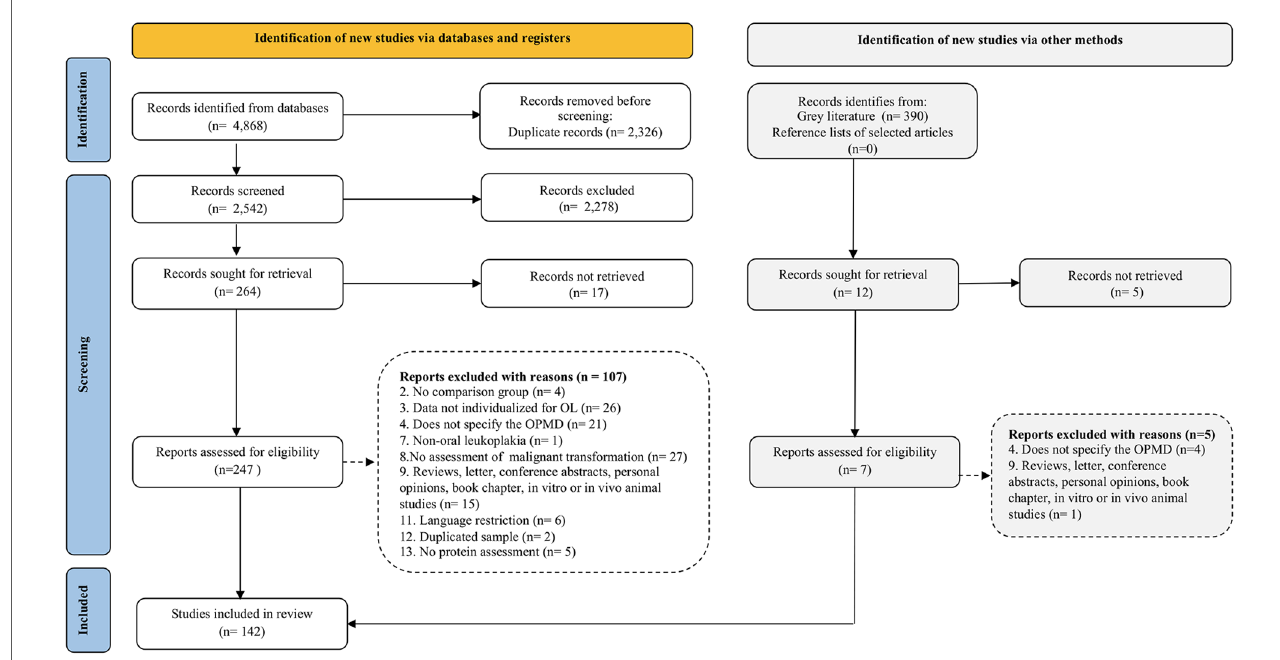
FIGURE 1 Flow diagram of literature search and selection criteria adapted from PRISMA 2020